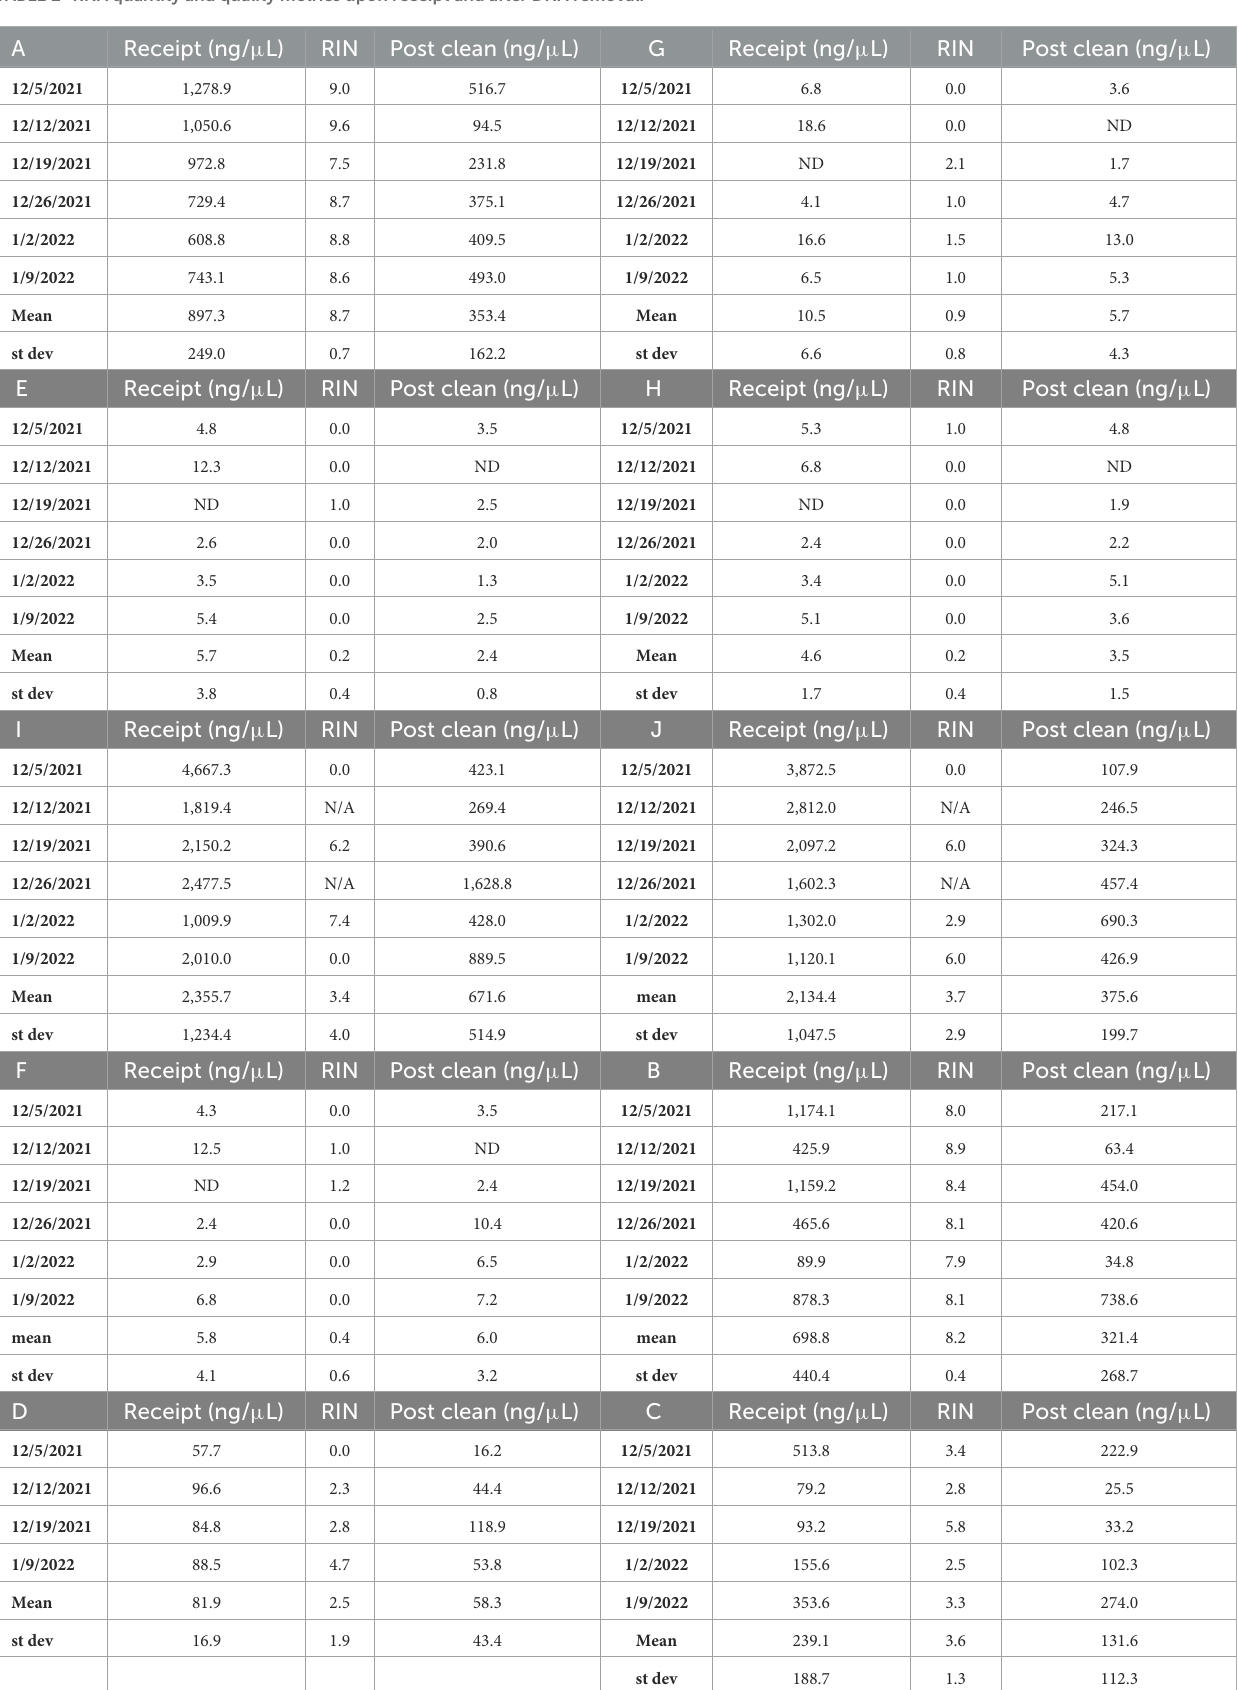
TABLE 2 RNA quantity and quality metrics upon receipt and after DNA